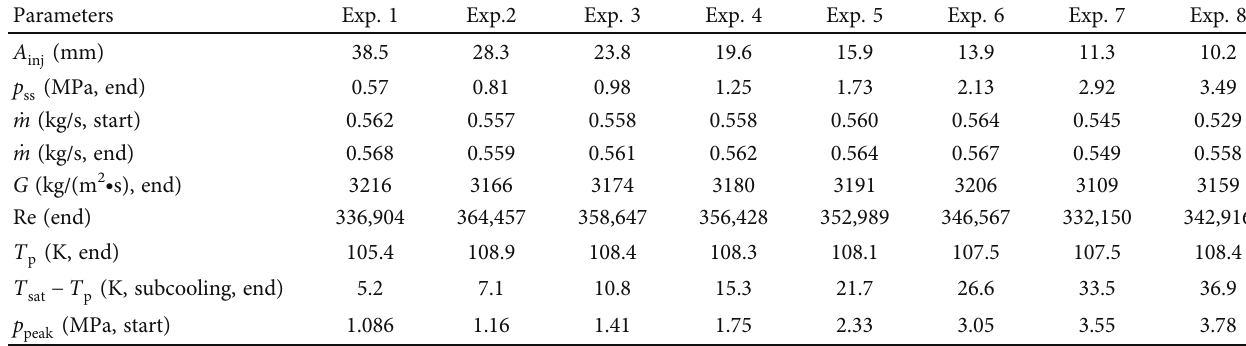
Table 2: Statistical t